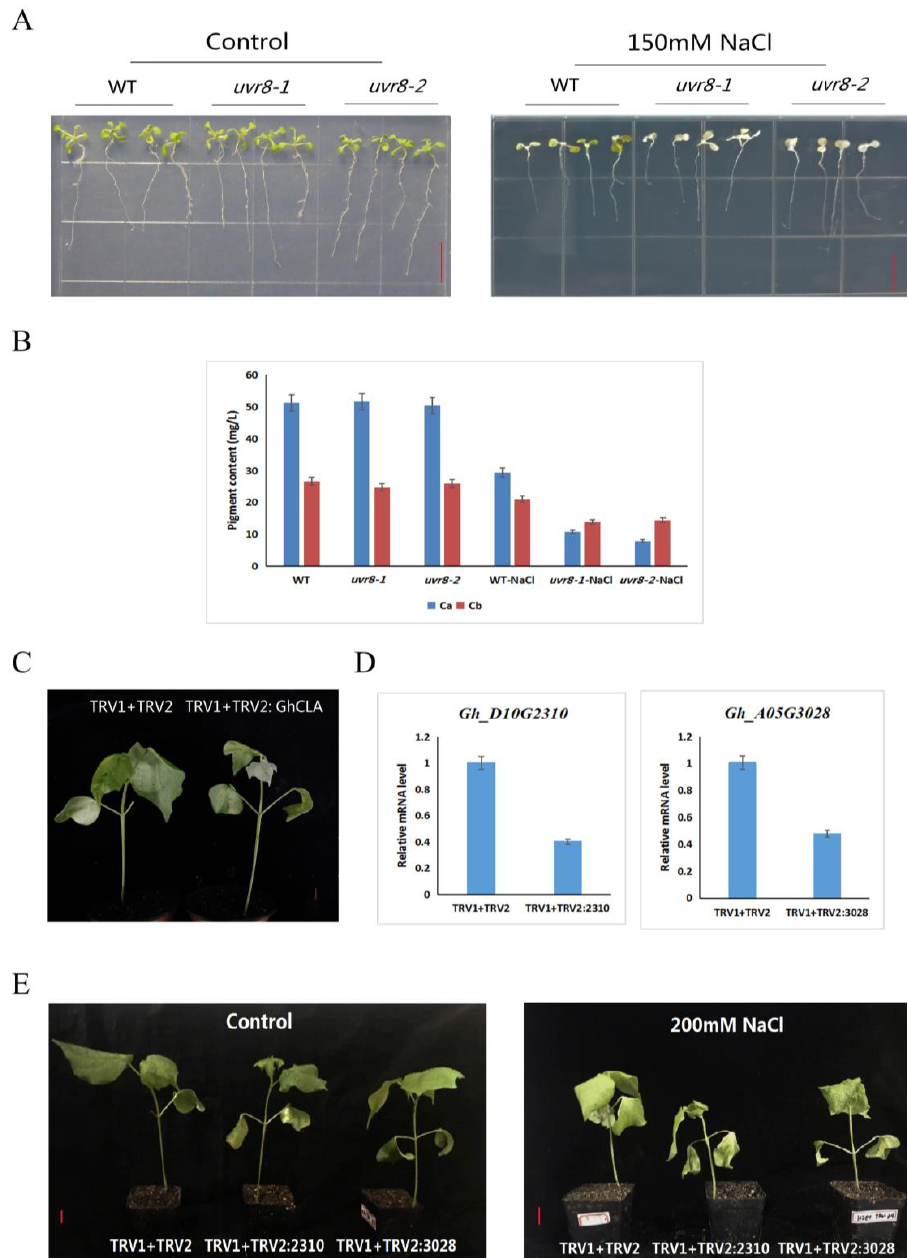
Figure 8. Phenotype of UVR8 mutants and Gh_A05G3028 and Gh_D10G2310 VIGS (virus induced gene silencing) plants under salt treatment. ( A ) Phenotypes of WT (wild-type) and UVR8 mutants of 7-day-old seedlings grown on 1/2 Murashige and Skoog (MS) media (control) and 1/2 MS media containing 150 um NaCl. WT: Col-0, uvr8-1 (SALK_072594C)/ uvr8-2 (SALK_072594C): T-DNA insertional mutants for UVR8 under the background of Col-0. ( B ) Determination of chlorophyll content in the wild-type and UVR8 mutants of Arabidopsis thaliana. Ca: chlorophyll a, Cb: chlorophyll b. Error bars represent the standard deviation of the three biological replicates. ( C ) Albino phenotypes in GhCLA1 VIGS plants. TRV1 + TRV2: negative control, TRV1 + TRV2: GhCLA: GhCLA1 VIGS plants. ( D ) Fluorescence quantitative PCR analysis of expression of Gh_A05G3028 and Gh_ D10G2310 in control and VIGS plants. TRV1 + TRV2: negative control, TRV1 + TRV2: 3028 and 2310: Gh_A05G3028 and Gh_D10G2310 VIGS plants. Error bars represent the standard deviation of the three biological replicates. ( E ) Phenotype of Gh_A05G3028 and Gh_D10G2310 VIGS seedlings under control and salt stress. All red bars are 1